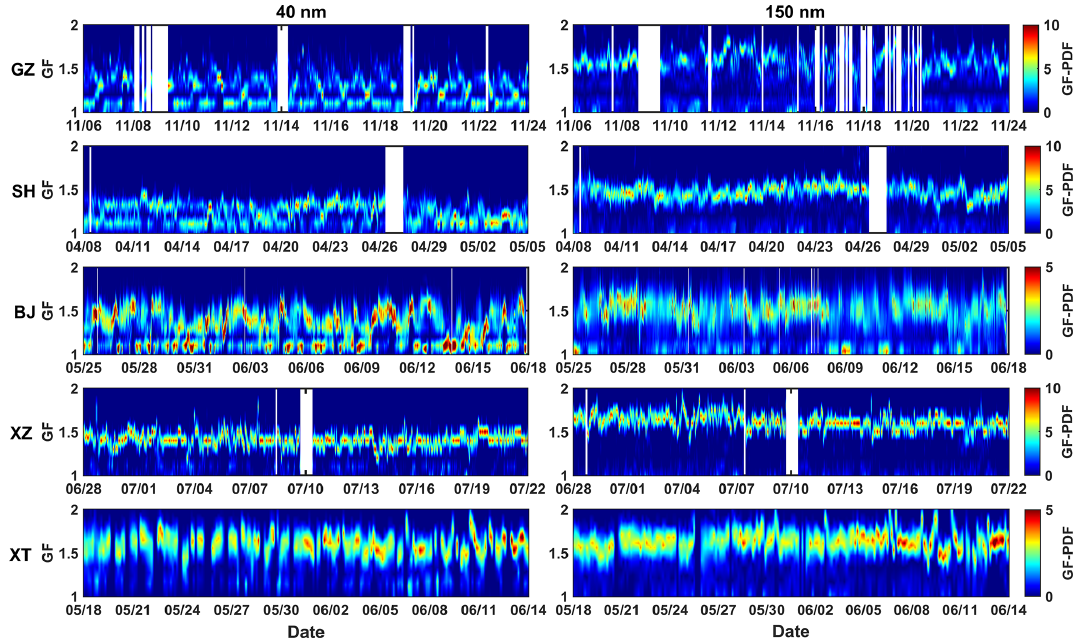
Figure 2. The time series of the probability density functions of growth factor (GF-PDFs) for 40 and 150nm particles at different sampling sites (GZ, SH, BG, XZ, and XT sites). The color scales denote the GF-PDF.